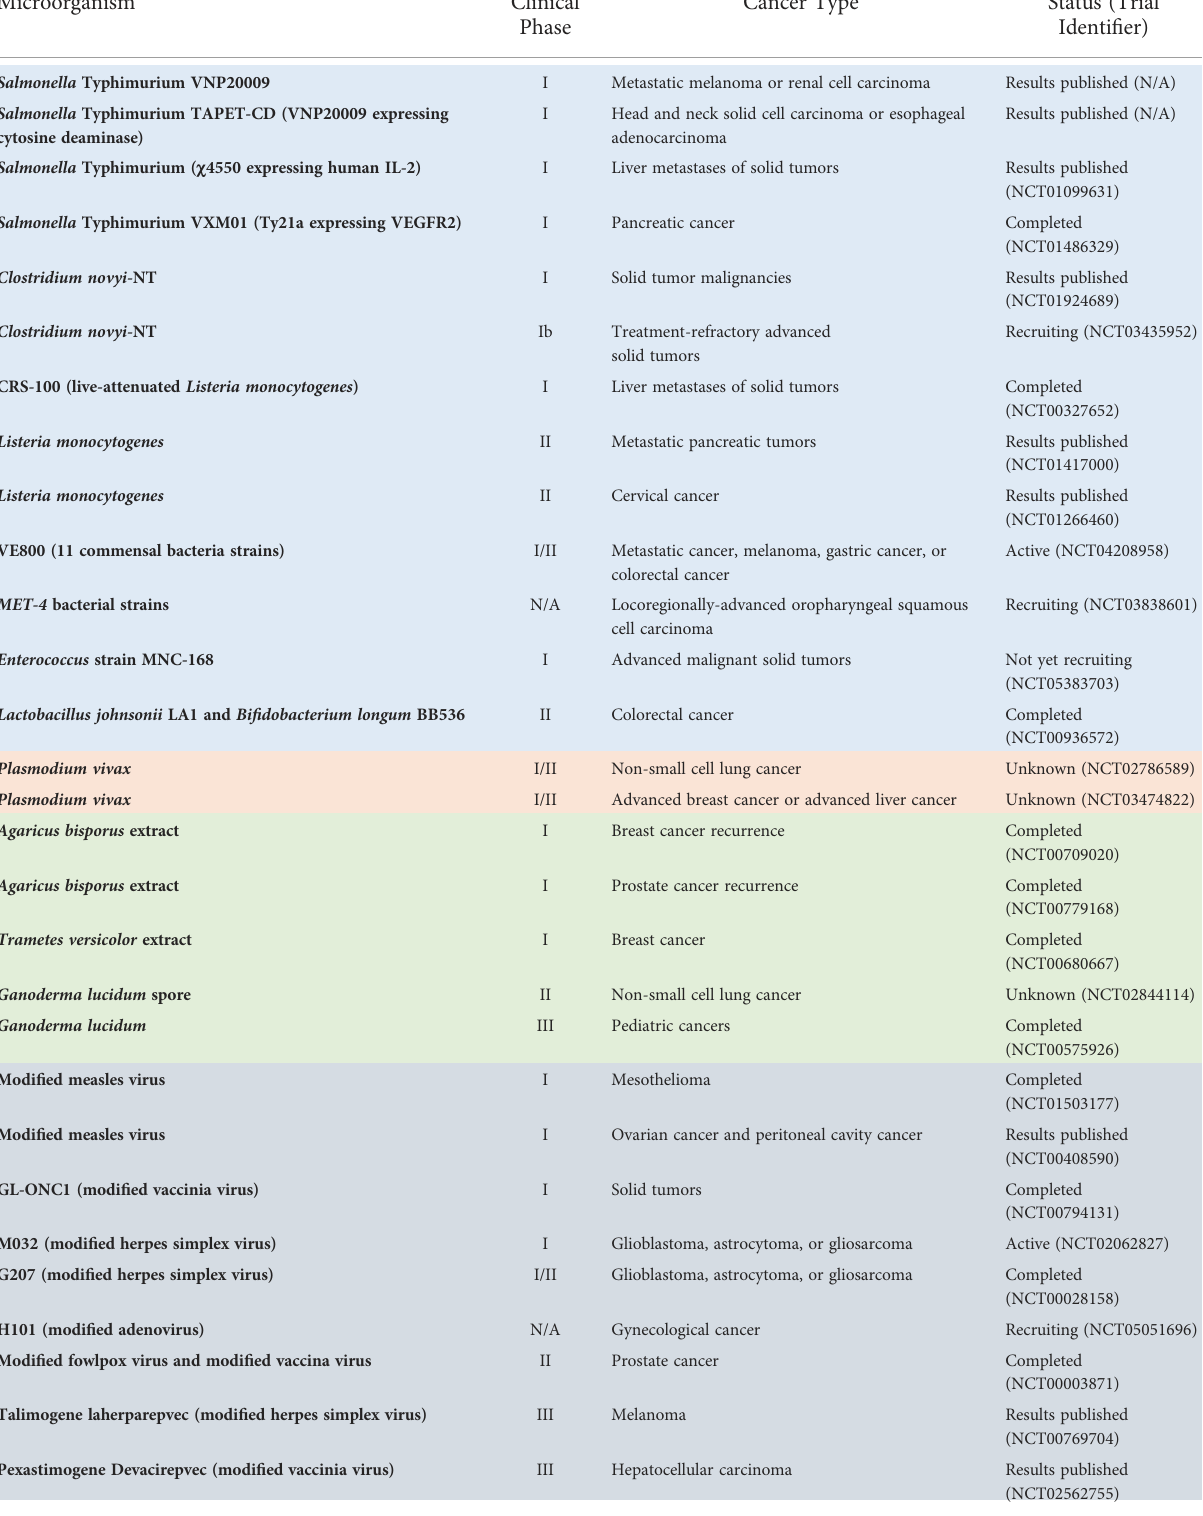
TABLE 1 Representative microorganisms applied for cancer